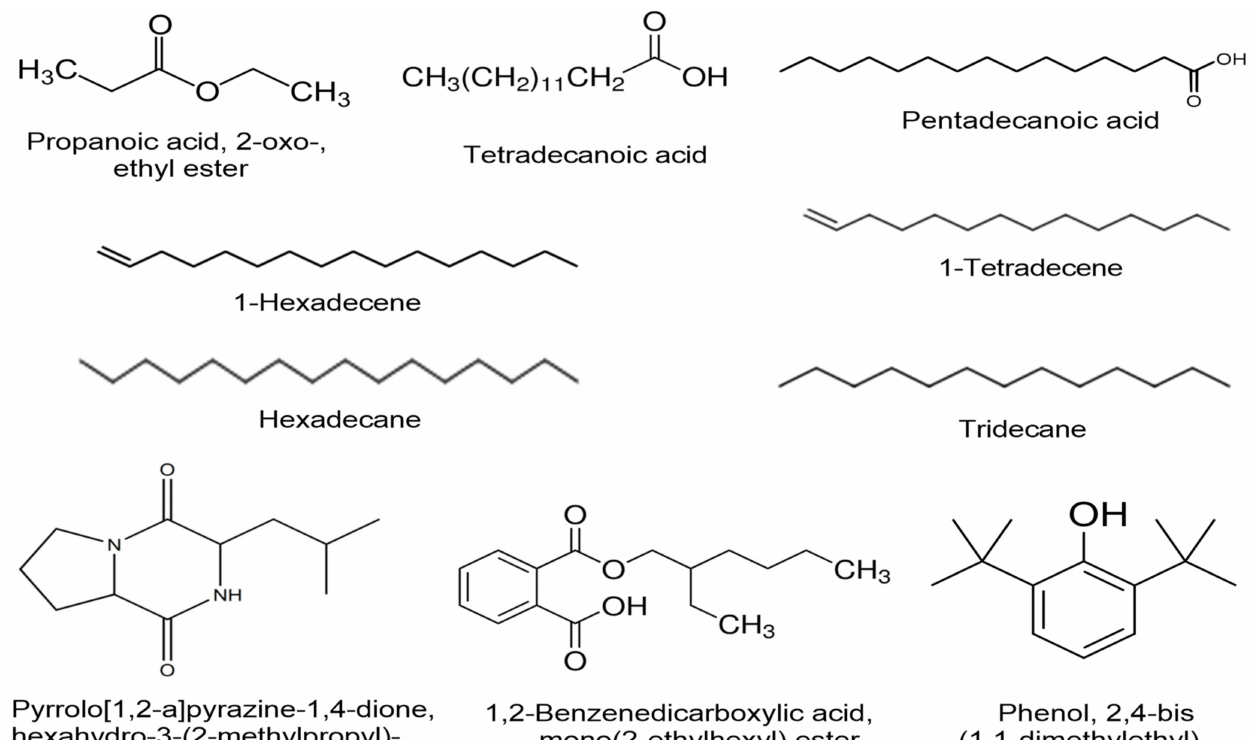
Figure 7. Chemical structures of the ten most abundant bioactive compounds detected in the GC–MS analysis of ethyl acetate extract of culture filtrate of Paenibacillus polymyxa isolate